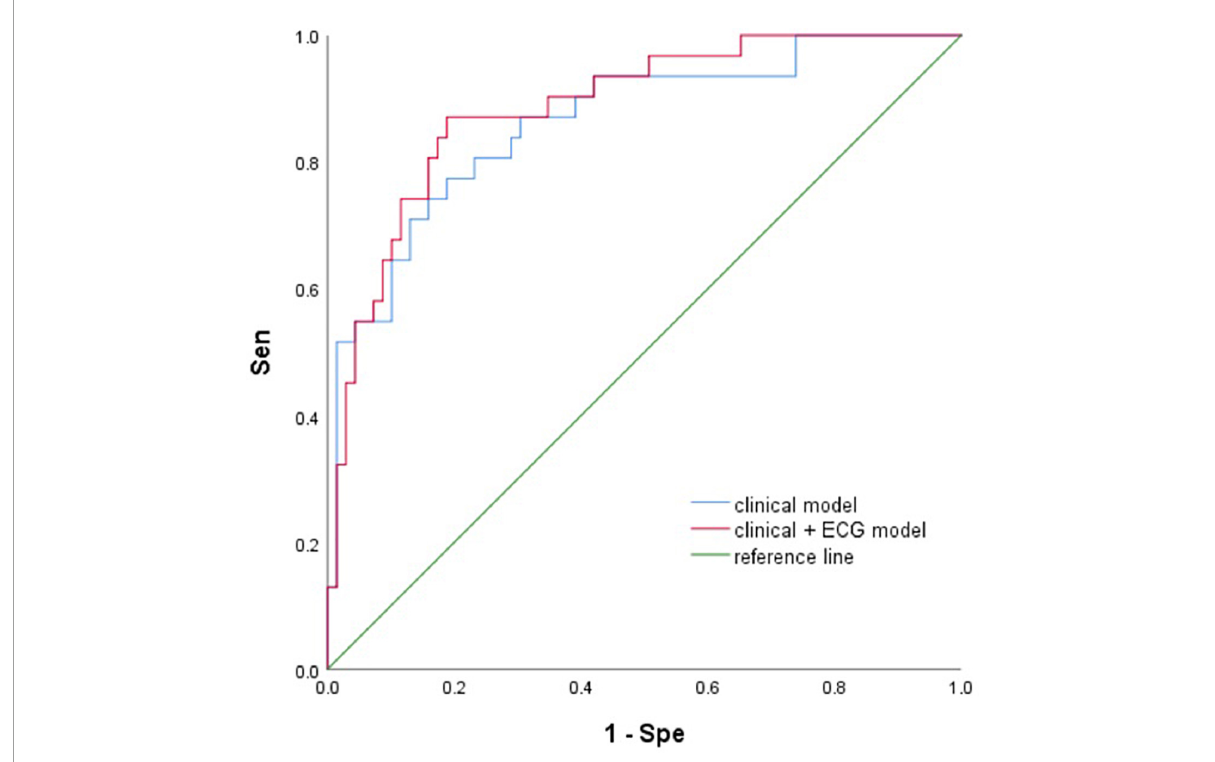
FIGURE4 The ROC of two models. Sen, sensitivity; Spe, specificity; ECG,